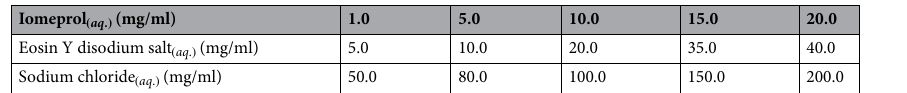
Table 5. Water-based diluted concentrations of the three basis materials (excluding distilled water itself) to determine the slope and intercept of a linear regression, which enables a more precisely calculation for the attenuation coefficients of the basis solutions.